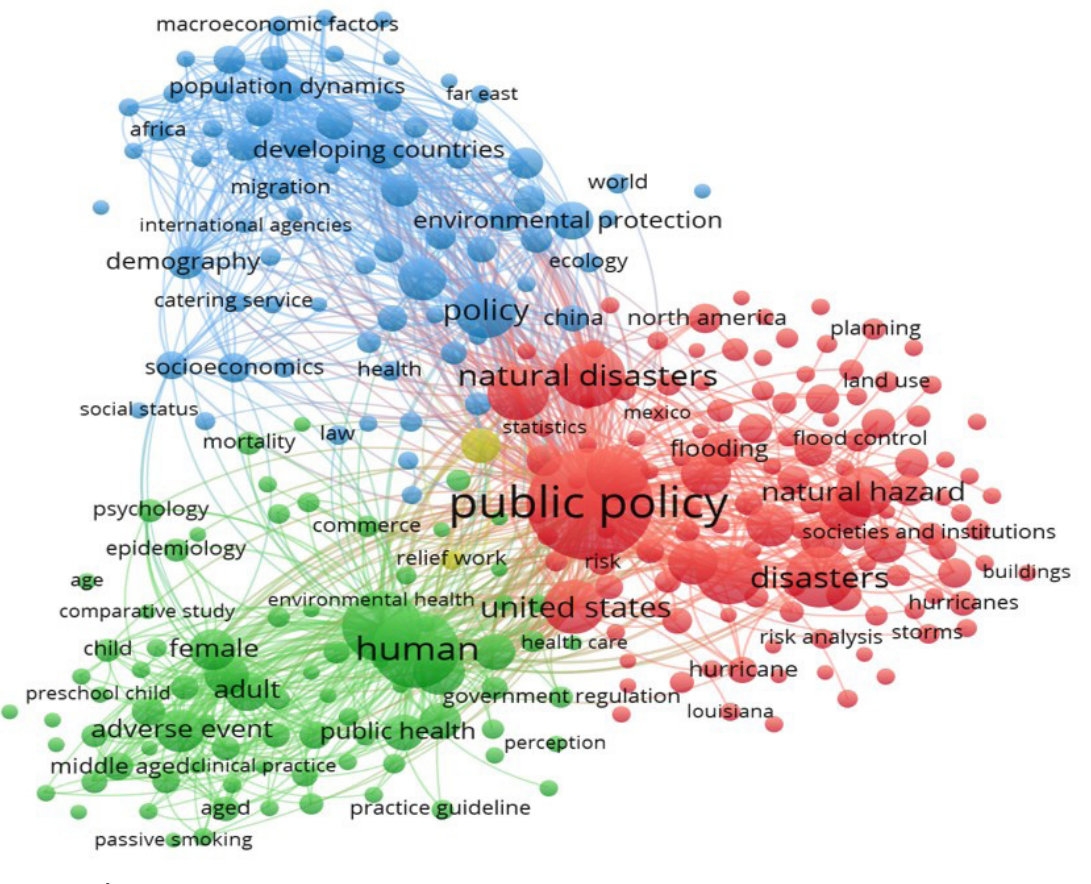
Figure 6. Keyword